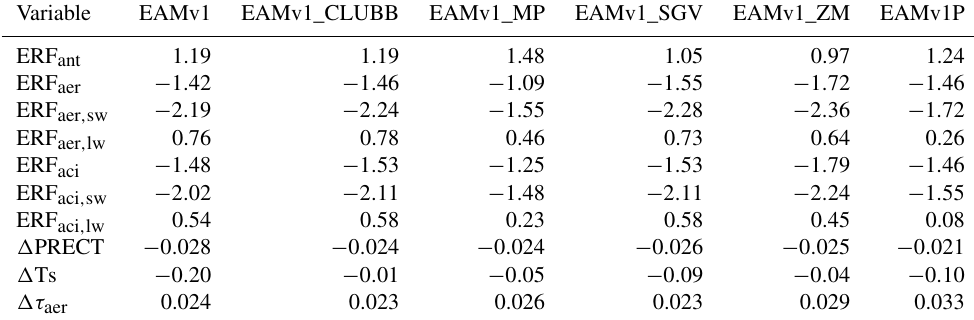
Table 9. Global mean 10-year-averaged total ERF ant derived from paired simulations with present-day and pre-industrial forcings. Short- wave, longwave, and net ERF aer ; shortwave, longwave, net ERF aci (unit = Wm − 2 ); and the difference in total precipitation rate (PRECT, unit = mmd − 1 ), land surface temperature (Ts; unit = K), and aerosol optical depth ( τ aer ) difference between paired simulations with present- day and pre-industrial aerosol emissions are also